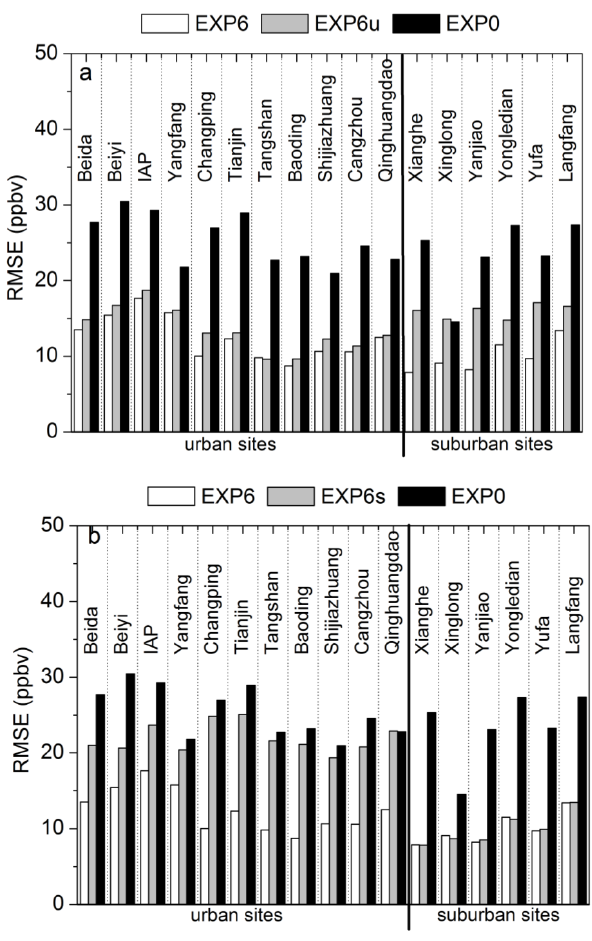
Fig. 11. (a) A comparison of the RMSEs of 1-hour ozone forecast at the 17 sites in EXP6u (with ozone observations at eleven urban sites assimilated) against those in reference experiment EXP0 and those in EXP6 (with ozone observations at all sites except for three independent sites assimilated). (b) A comparison of the RMSEs of 1-hour ozone forecast at the 17 sites in EXP6s (with ozone observations at six suburban sites assimilated) against those in reference experiment and those in EXP6.